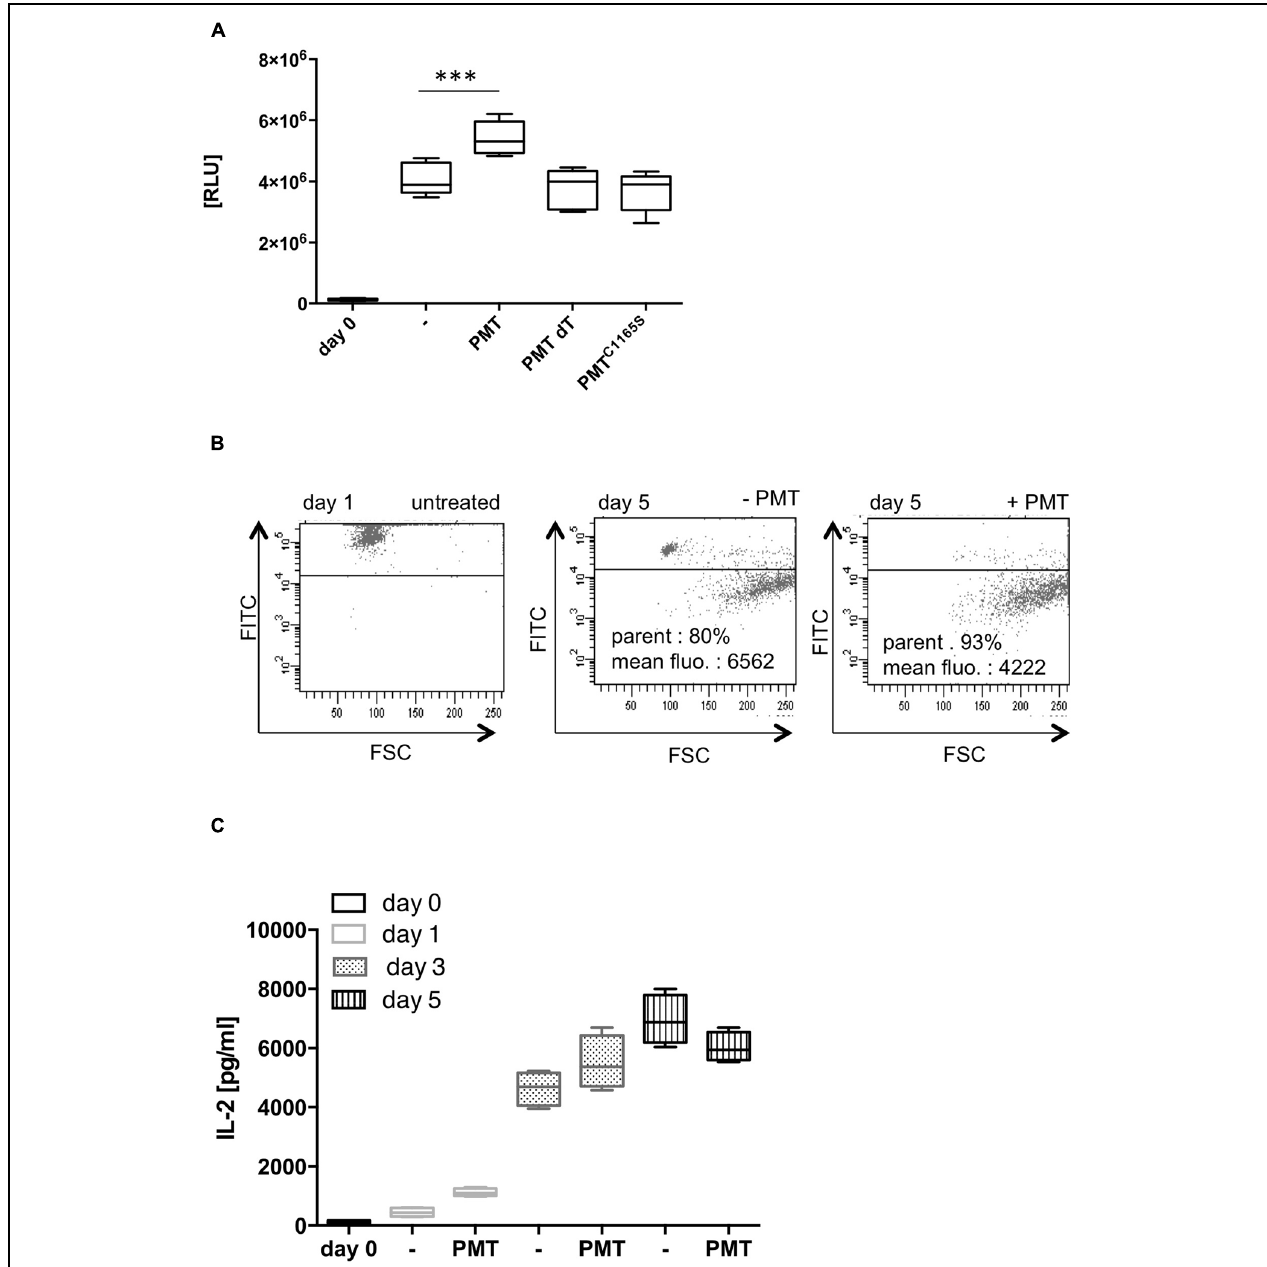
FIGURE 1 | Pasteurella multocida toxin (PMT) stimulates CD3/CD28-activated T cell proliferation. (A) CD4-positive T cells were activated with anti-CD3/CD28-coated beads (T Cell Activation/Expansion Kit, Miltenyi) and stimulated for 5 days with 1 nM PMT wild-type (wt), heat-inactivated PMT (dT), or a catalytically inactive mutant (PMT C1165S ). Viability of cells was determined by quantification of ATP using the CellTiter-Glo R (cid:3) Luminescent Cell Viability Assay (Promega). Shown is the mean ± SD, n = 6 (six donors, each experiment performed in duplicates). (B) Th cells were CFSE-labeled, CD3/CD28-activated and stimulated for 5 days with 1 nM PMT. Proliferation cycles were assayed by measuring the decreasing fluorescence by flow cytometry. The mean fluorescence and percentages refer to the gated (dividing) cells. Shown is the result of one representative donor out of three. (C) CD3/CD28-activated Th cells were stimulated with PMT for 1, 3, or 5 days. IL-2 ELISAs were performed (mean ± SD, n = 4; four donors, each experiment performed in duplicates). Statistical analysis was performed using two-sided ANOVA for multiple comparisons ( ∗∗∗ p ≤